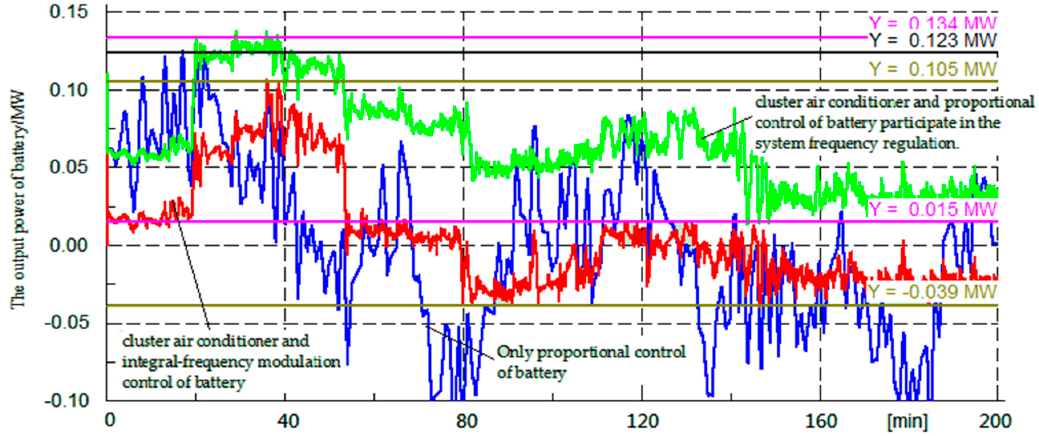
Figure 10. The power curves of battery with different frequency regulation methods.